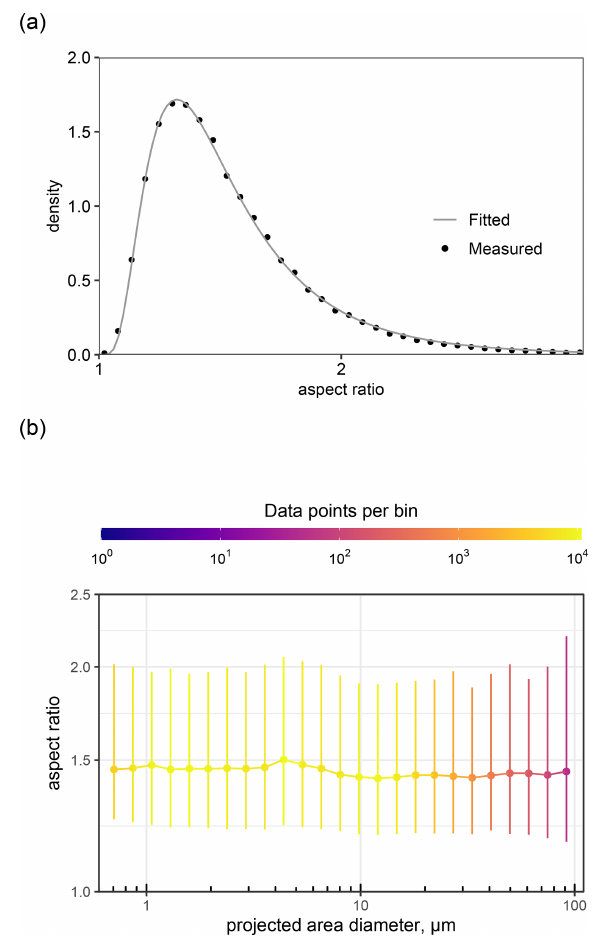
Figure 11. (a) Measured and parameterized (solid line) aspect ra- tio density distribution of dust particles. (b) Size-resolved particle aspect ratio. The bar range represents the range between the 0.1 and 0.9 quantiles, the dot is the median, and the bins are color coded by the number of data points within each